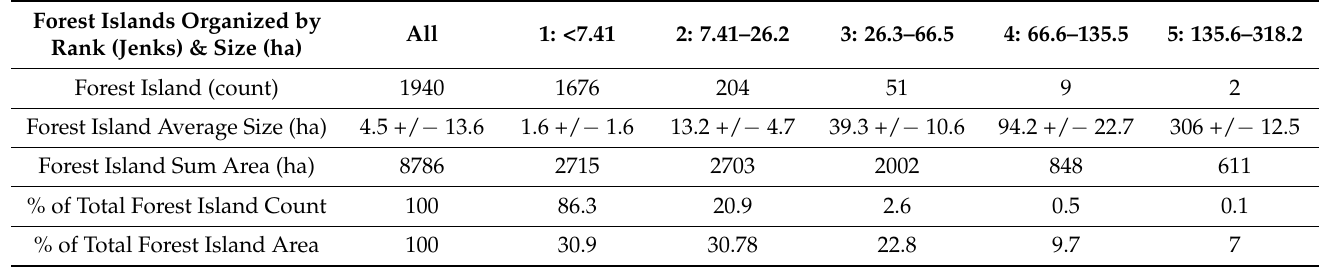
Table 2. Average and total area for forest islands sorted into ranks according to